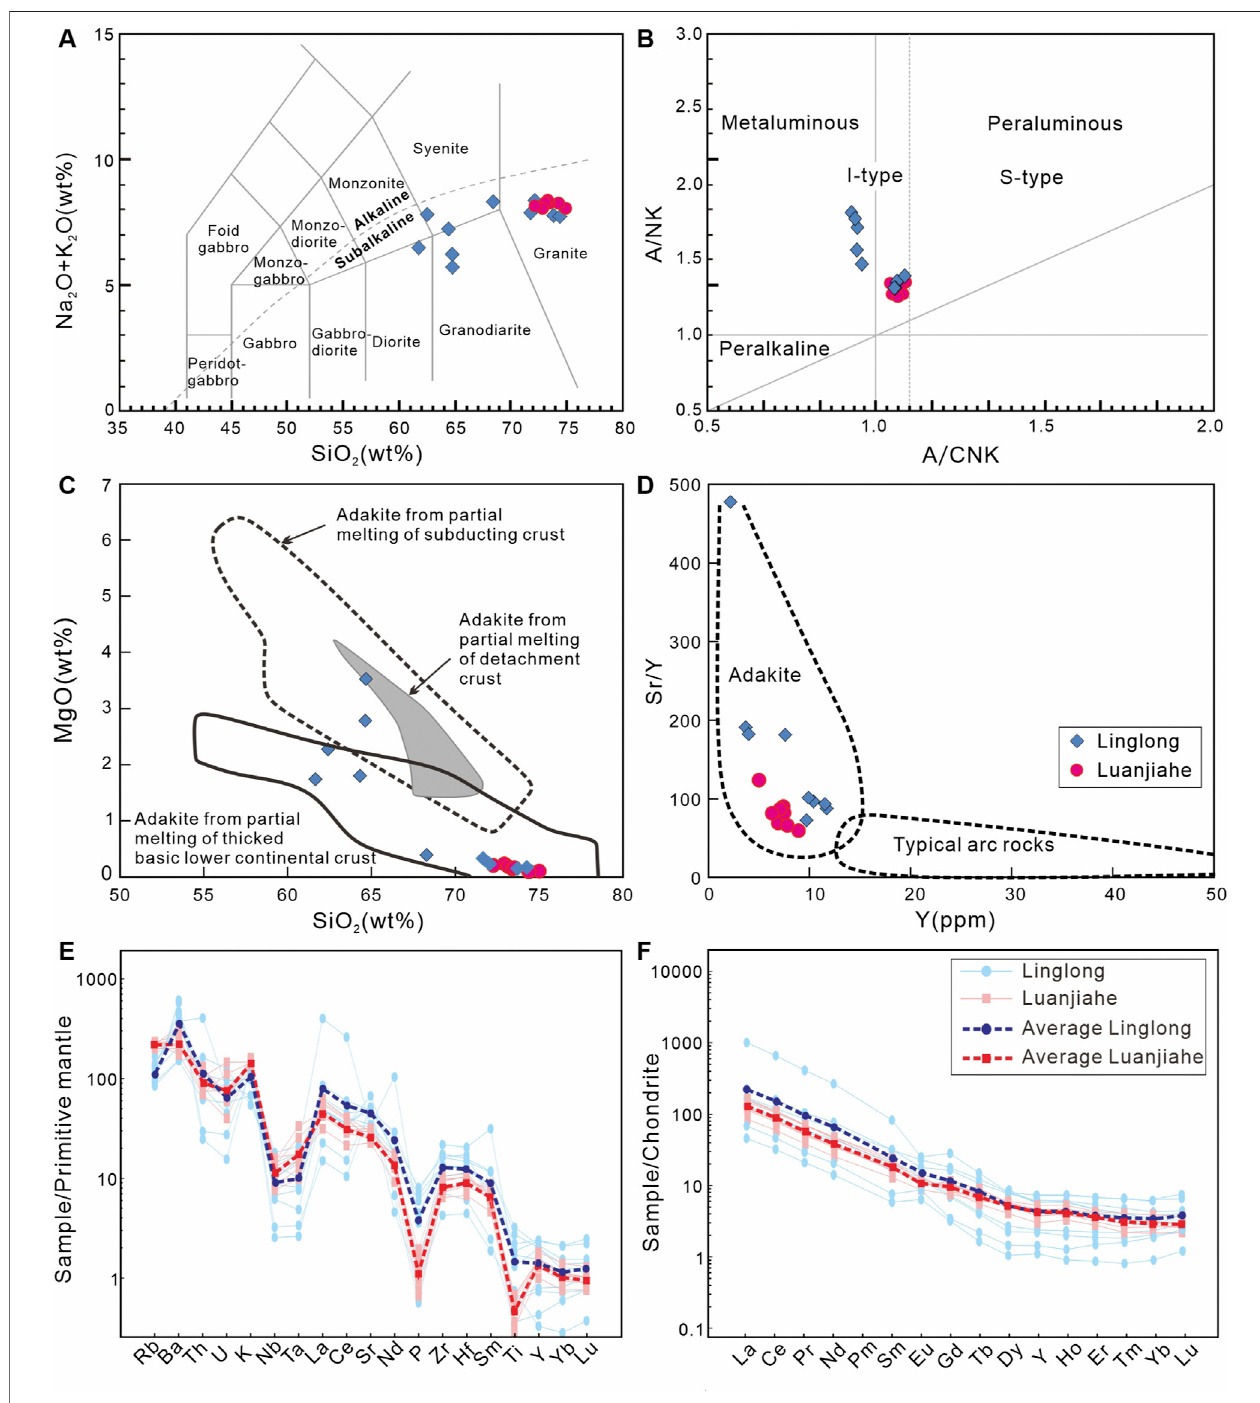
FIGURE3|(A) PlotsofSiO 2 vsNa 2 O+K 2 Oand (B) A/CNK(molarAl 2 O 3 /(CaO+Na 2 O+K 2 O))(afterIrvineandBaragar,1971)vsA/NK(molarAl 2 O 3 /(Na 2 O+K 2 O)) (after Maniar and Piccoli, 1989) (C) Plots of SiO 2 vs MgO (after Lai and Qin, 2013) and (D) Y vs Sr/Y (after Defant and Drummond, 1990) (E) Primitive mantle-normalized trace element and (F) Chondrite-normalized REE diagrams for the Linglong and Luanjiahe granites. Normalized values are from Sun and McDonough (1989).